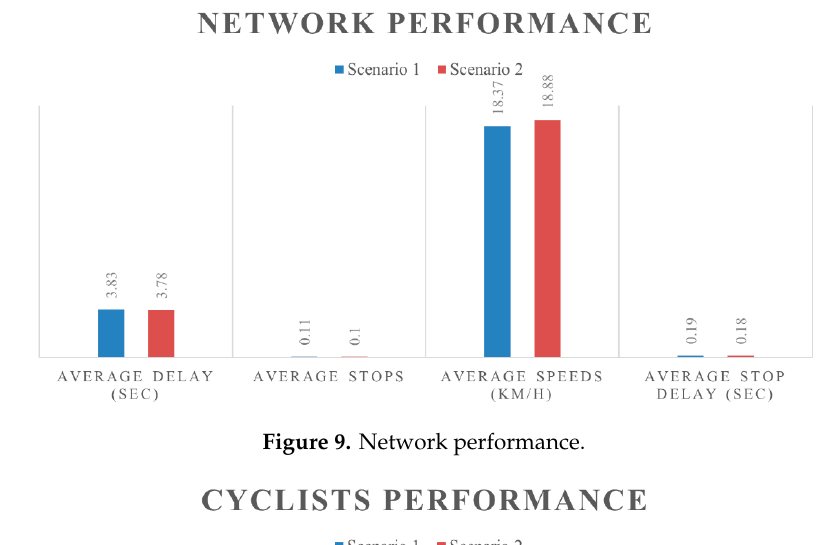
Figure 9. Network performance.